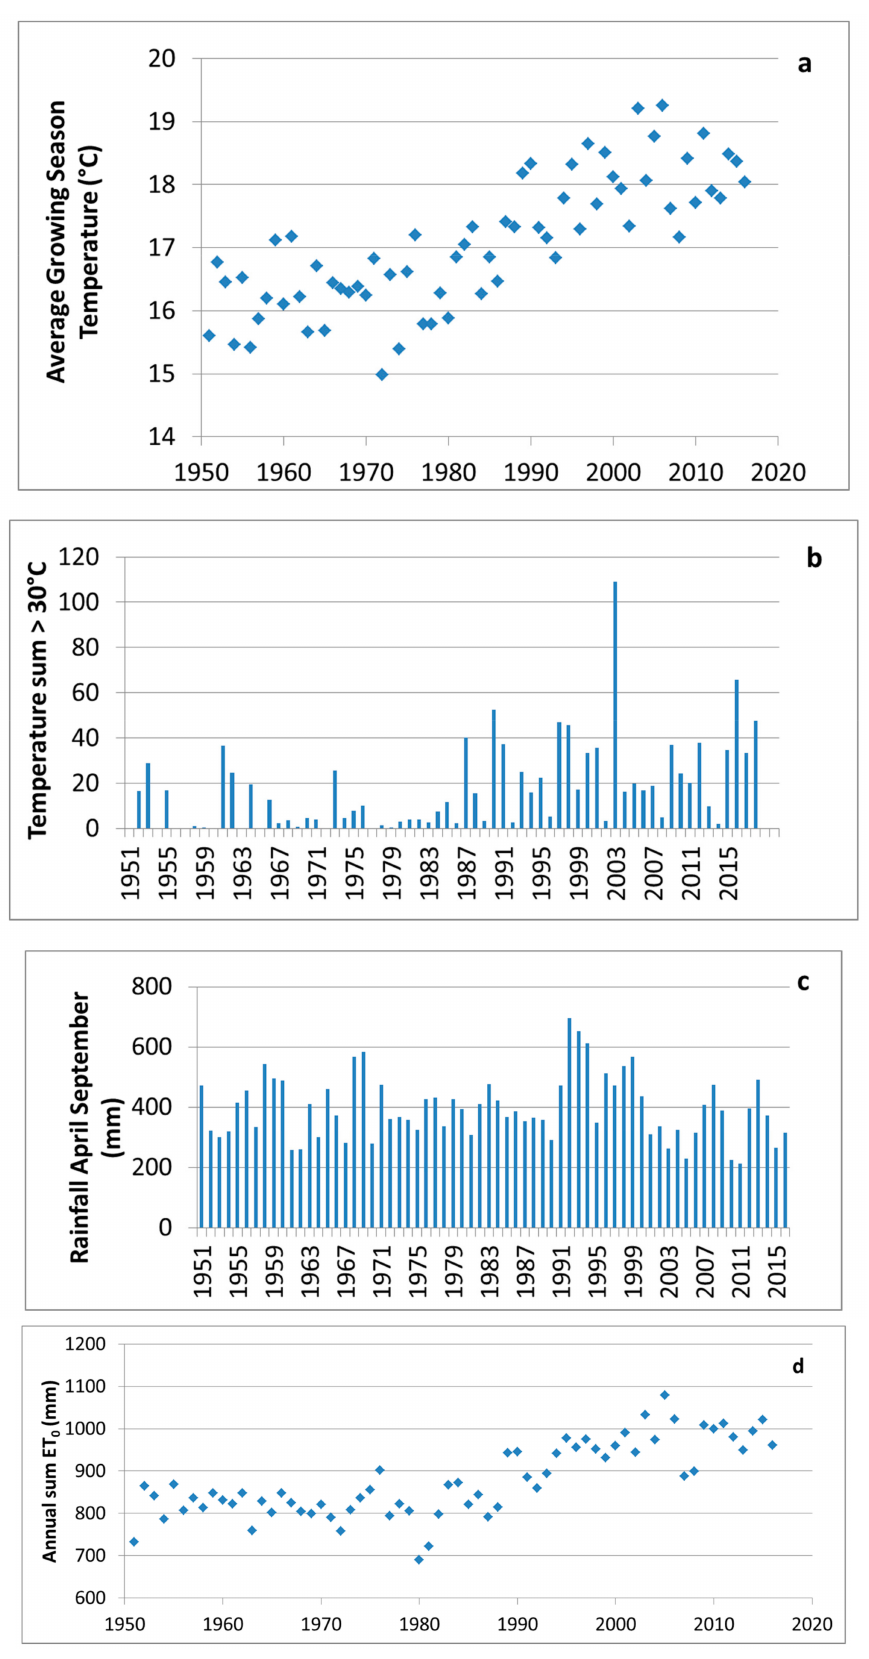
Figure 1. Climate data for Bordeaux (Bordeaux M é rignac weather station) from 1951 to 2018: ( a ) average growing season temperature, ( b ) temperature sum > 30 ◦ C during 45 days prior to harvest, ( c ) rainfall April–September, ( d ) annual sum of reference evopotranspiration (ET 0